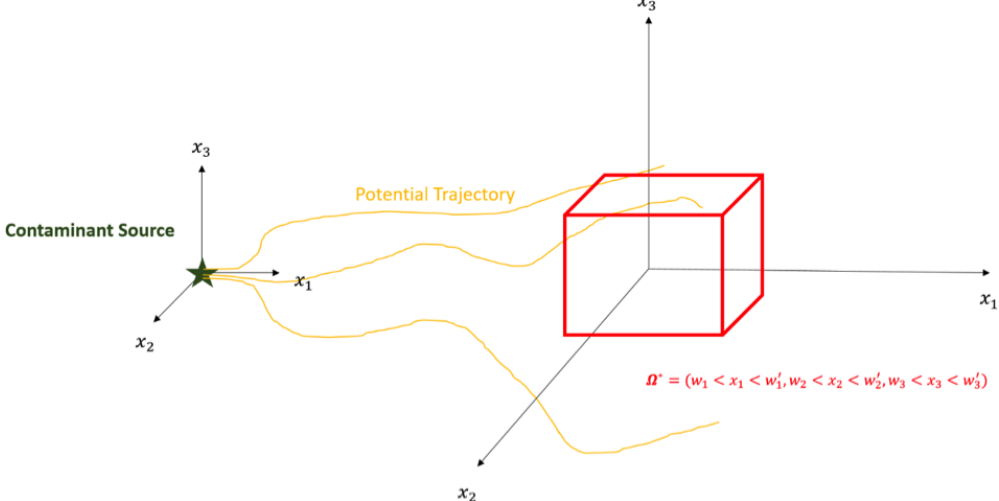
Figure 3. Configuration of the synthetic case study. x 1 , x 2 and x 3 represent the longitudinal, transverse and vertical directions, respectively. w 1 , w (cid:48) , w 2 , w (cid:48) , w 3 and w (cid:48) are the coordinates that set up the volume of (cid:127) ∗ 1 2 3